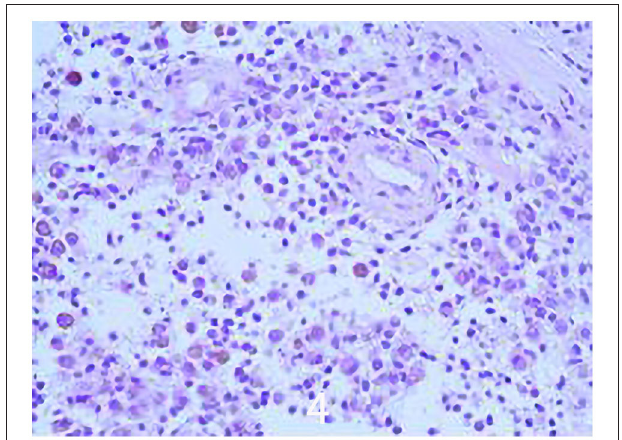
FIGURE 4 | Histological image showing a tumor characterized by a cleft-like space growth lined by synovial-like cells and a mixed cellular component made-up of mononuclear round small and large discohesive cells, rare osteoclast-like giant cells, and inflammatory cells (Hematoxylin and Heosinstained (H & H) section; original magnification × 100).